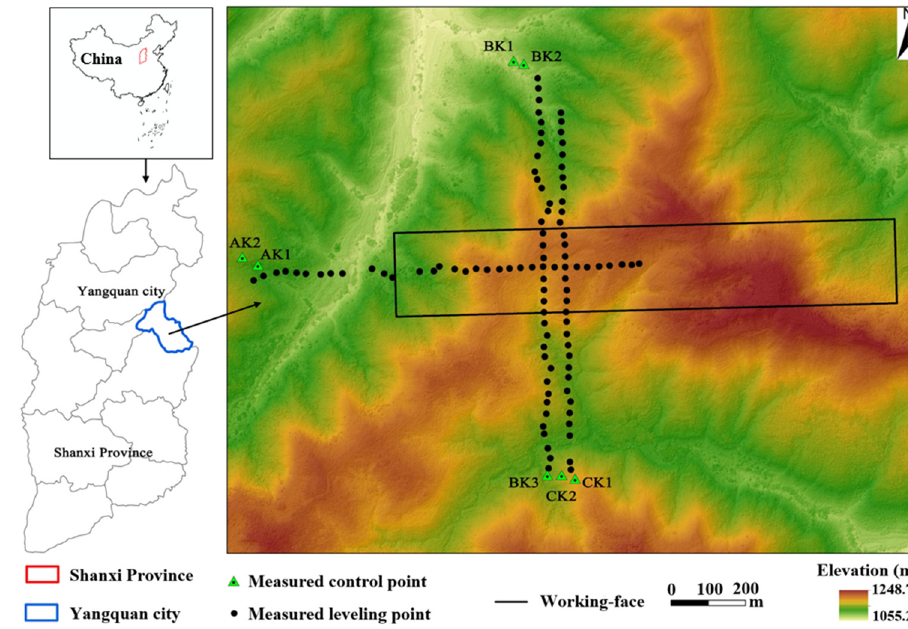
Figure 1. The geographic position of study area, working face, and measured leveling point.